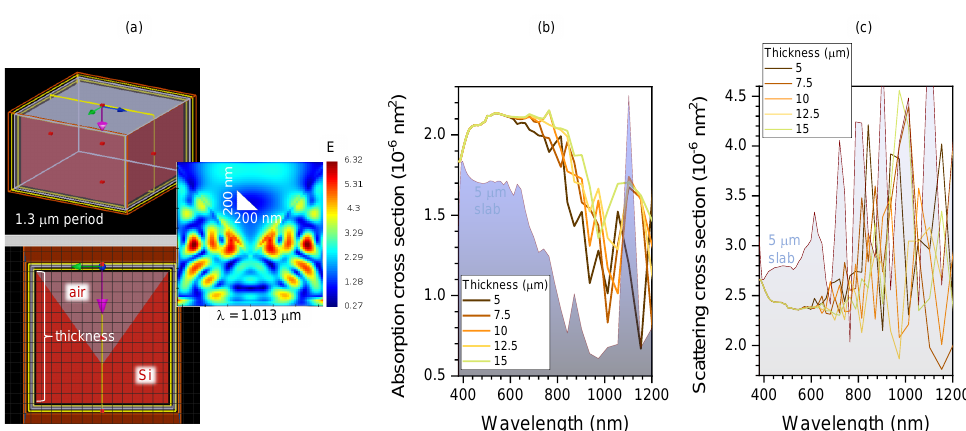
Figure 1. Numerical modelling of light trapping by photonic crystal (PhC) on Si. ( a ) Numerical model and a central cross-section of light enhancement in 1.3 µ m-thick Si; period of PhC Λ = 1.3 µ m. Calculated by finite difference time domain (FDTD) (Lumerical, Ansys). ( b ) Absorption cross-section σ ab of Si of different thicknesses for PhC Λ = 1.3 µ m. The background spectral profile is for a flat slab of Si of 5 µ m. ( c ) Corresponding scattering cross-sections σ sc . The indirect Si bandgap at 300 K is 1.12 eV or a 1.107 µ m